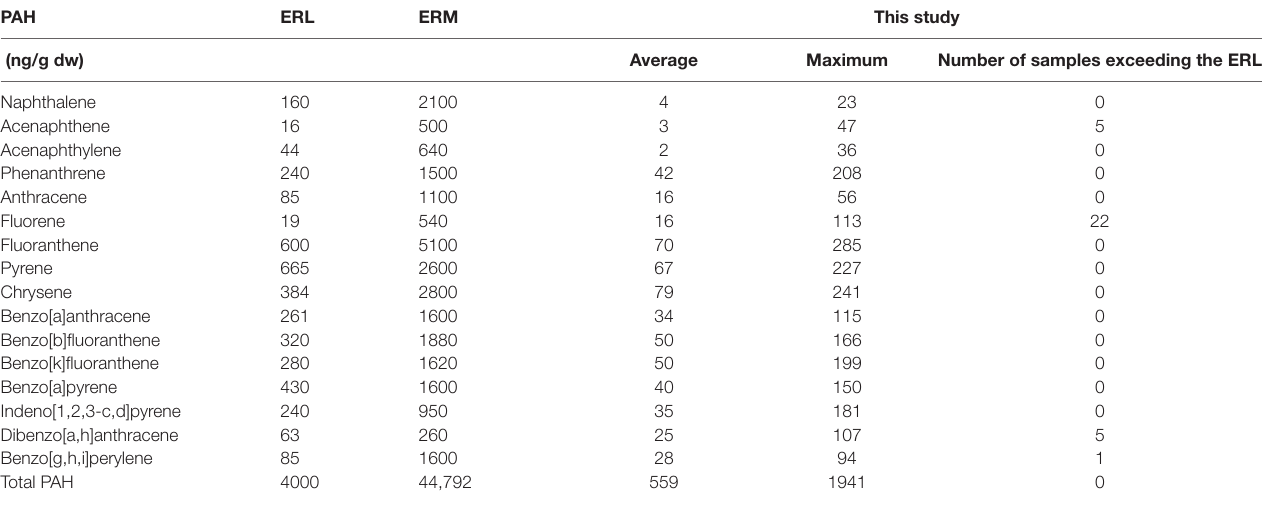
TABLE 3 | Results of ecological risk assessment for sediment samples in the study area from 2003 to 2013. PAH ERL ERM This study (ng/g dw) Average Maximum Number of samples exceeding the ERL Naphthalene